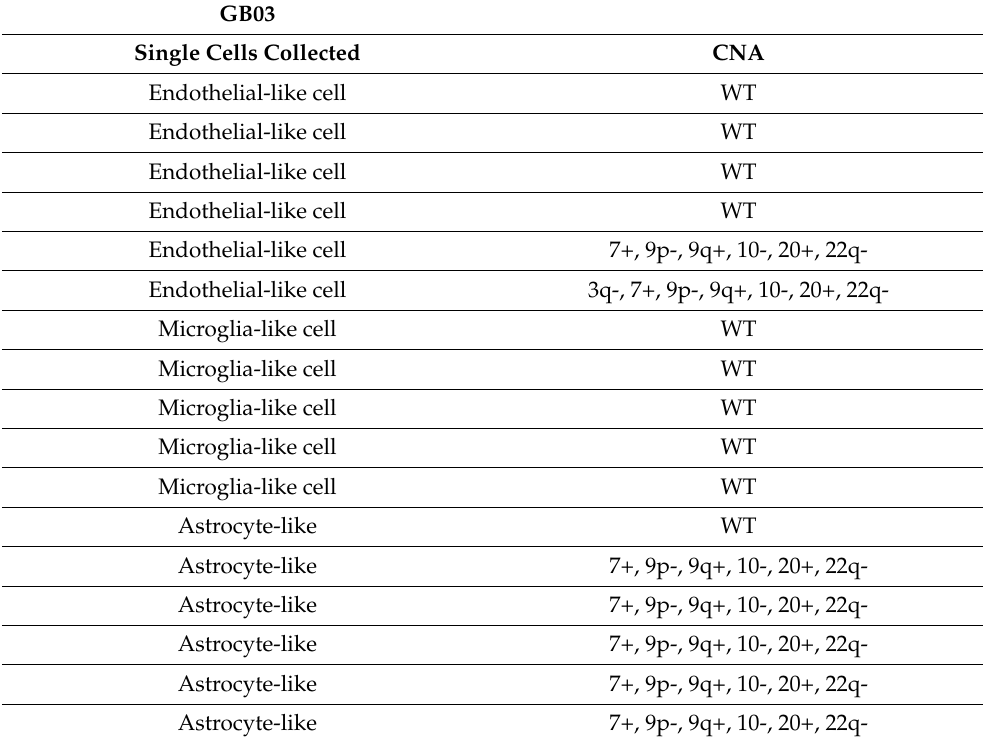
Table 4. CNAs results obtained after CNApp processing for single cells and groups of single cells collected in the GB03